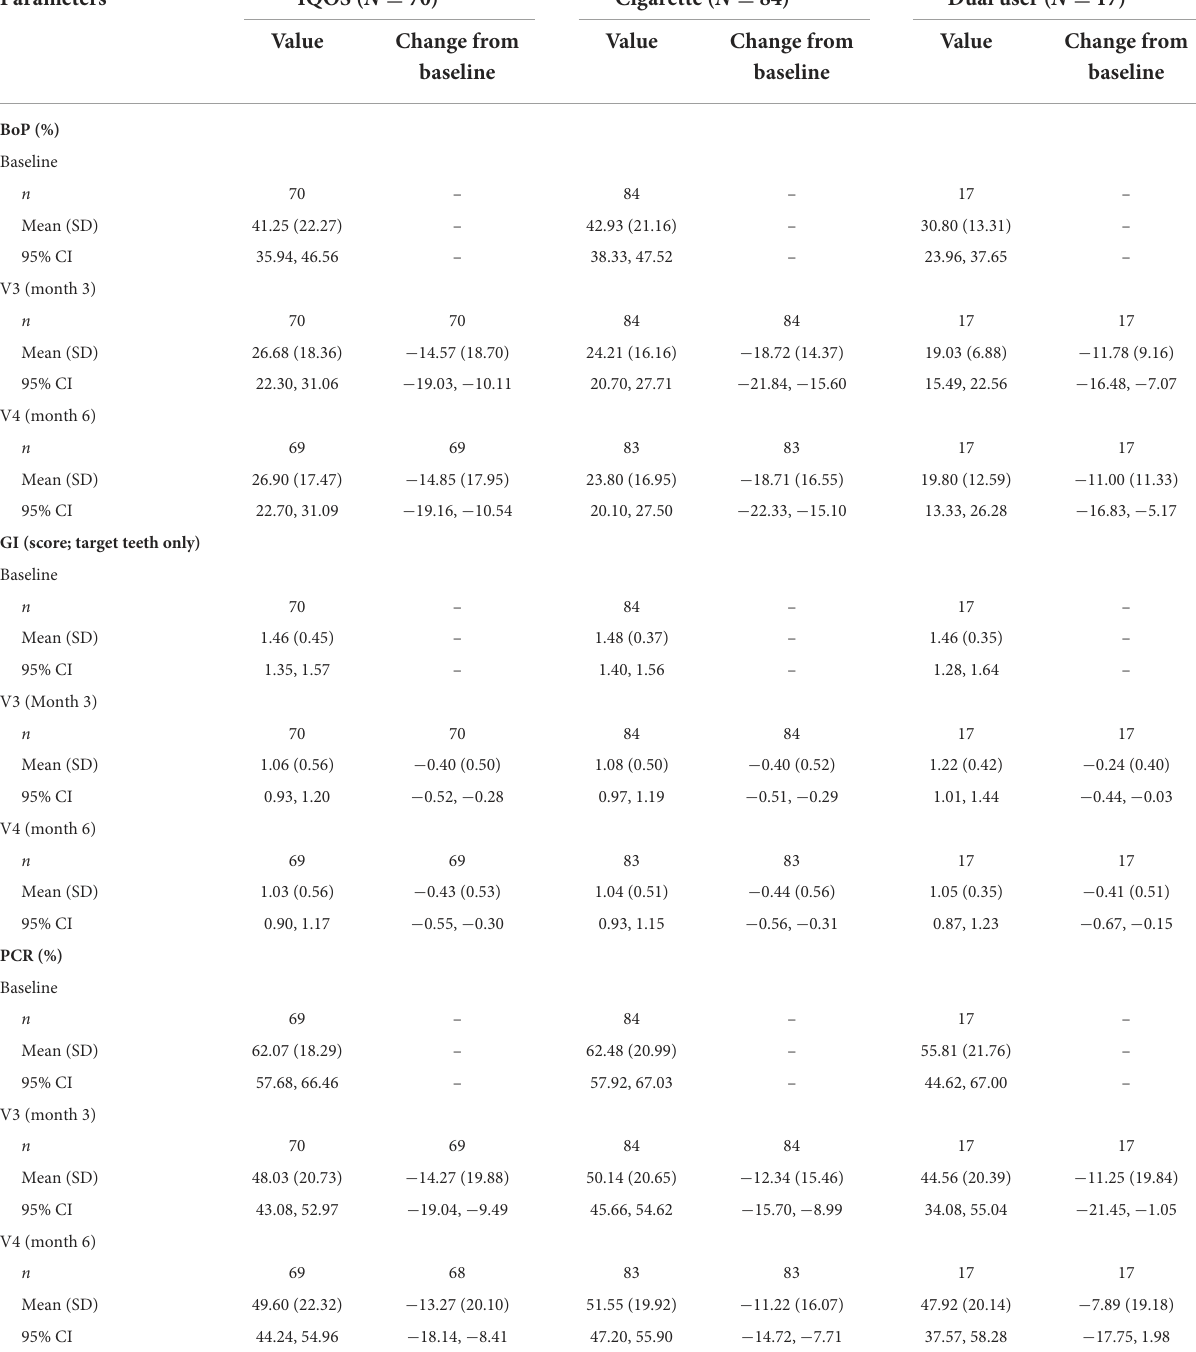
TABLE 2 Descriptive statistics of BoP, GI, and PCRs and in the As Exposed